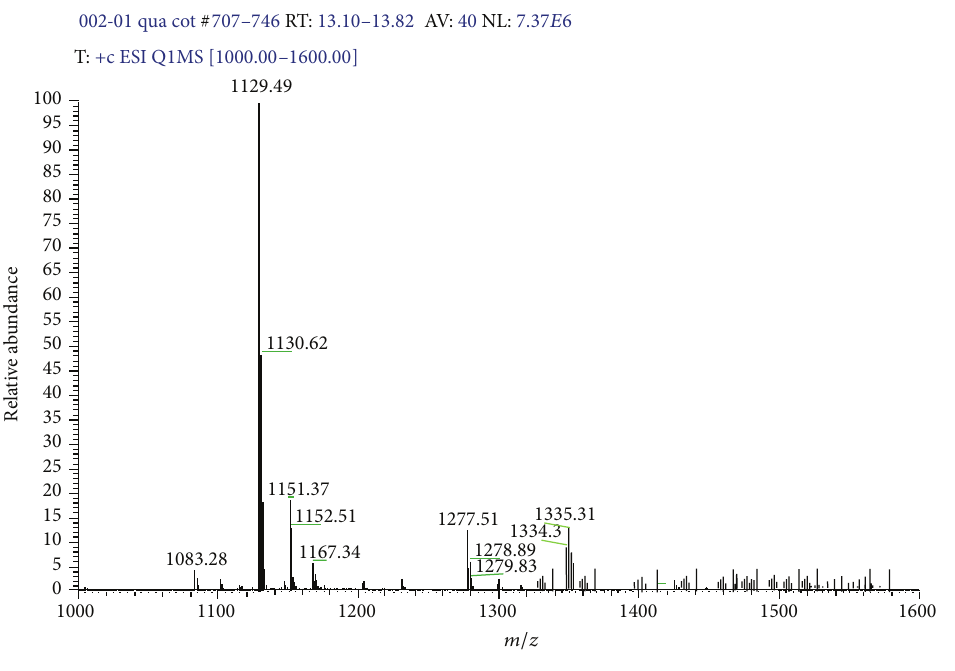
Figure 9: ESI-MS spectra of complex